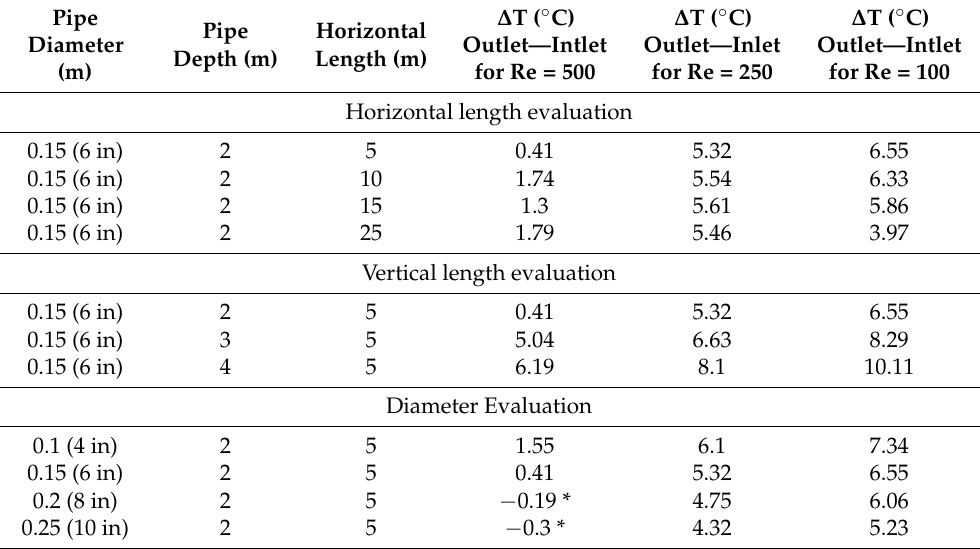
Table 11. Numerical evaluation of the heating potential according to the dimensions of the GAHE.